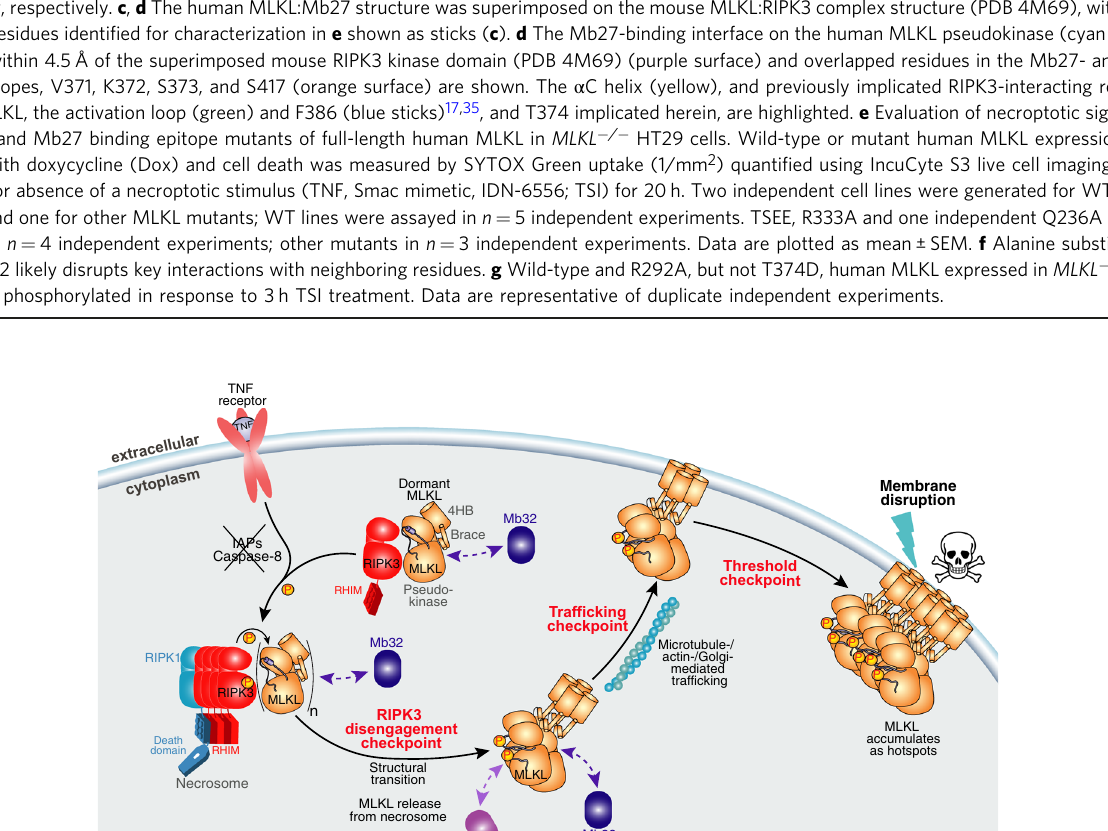
Fig. 5 Summary of regulatory checkpoints in human MLKL activation. Necroptosis is initiated by ligand binding to cell surface death receptors, such as TNF receptor 1, when the IAP E3 ubiquitin ligases and Caspase-8 are depleted or inhibited. Immunoprecipitation using Mb32 identi fi ed MLKL to exist in complex with RIPK3 prior to initiation of necroptosis. The RIPK3:MLKL complex is recruited to a RIPK1-nucleated platform (the necrosome) following induction of necroptosis, where RIPK3 is autophosphorylated and MLKL phosphorylated by RIPK3. Subsequently, oligomeric phosphorylated MLKL (pMLKL) disengages from RIPK3, which permits its recognition by Mb27. Phospho-MLKL oligomers are subsequently traf fi cked to the plasma membrane 31 via the Golgi-/actin-/microtubule-traf fi cking machinery 32 . pMLKL accumulates at the plasma membrane into higher order hotspots, and when a threshold amount of MLKL is surpassed, MLKL ruptures the plasma membrane to induce cell death and release of pro-in fl ammatory DAMPs 32 . Monobody-27 and Monobody-32 are depicted in light and dark purple colors, respectively; dashed lines represent the interactions observed for Mb27 and Mb32 in HT29 cells. The skull and crossbones image (Mycomorphbox_Deadly.png; artist, Sven Manguard) was sourced under a Creative Commons Attribution-Share Alike 4.0